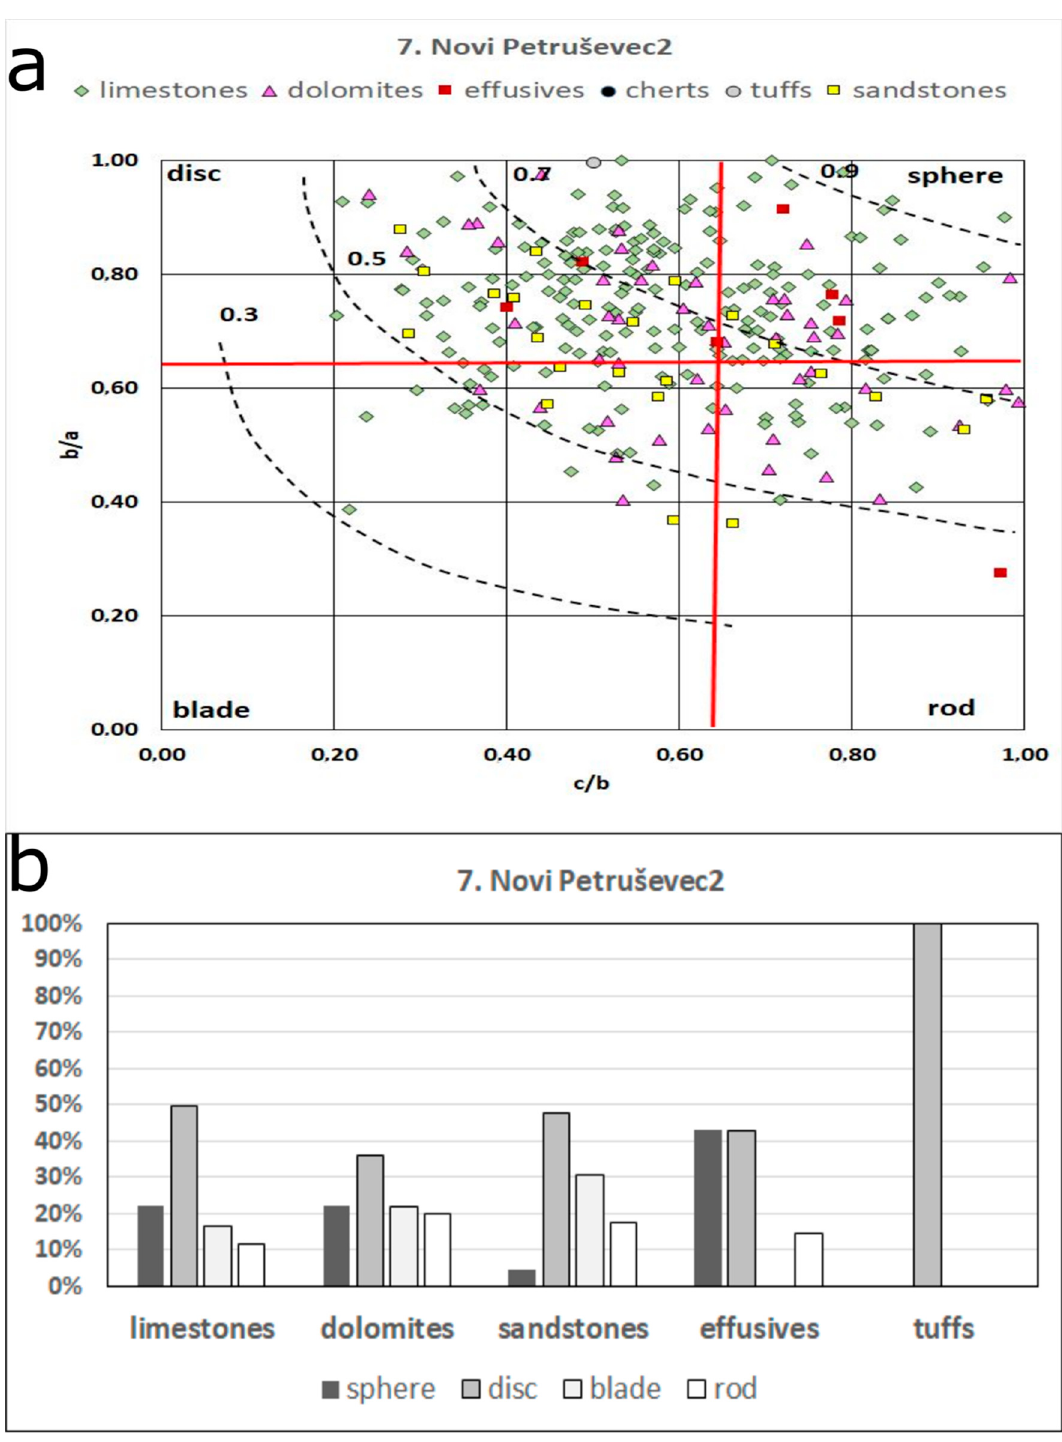
Figure 13. Pebble shapes of main lithotypes in Novi Petruševec 2: ( a ) Zingg diagram; ( b ) histograms. In Ivanja Reka, the far east location, all major lithotypes are significantly present again. Limestones are predominant and slightly increase again, having mainly disc to sphere pebble shapes (Figure 14). Sandstone pebbles with mainly blade shapes prevail.